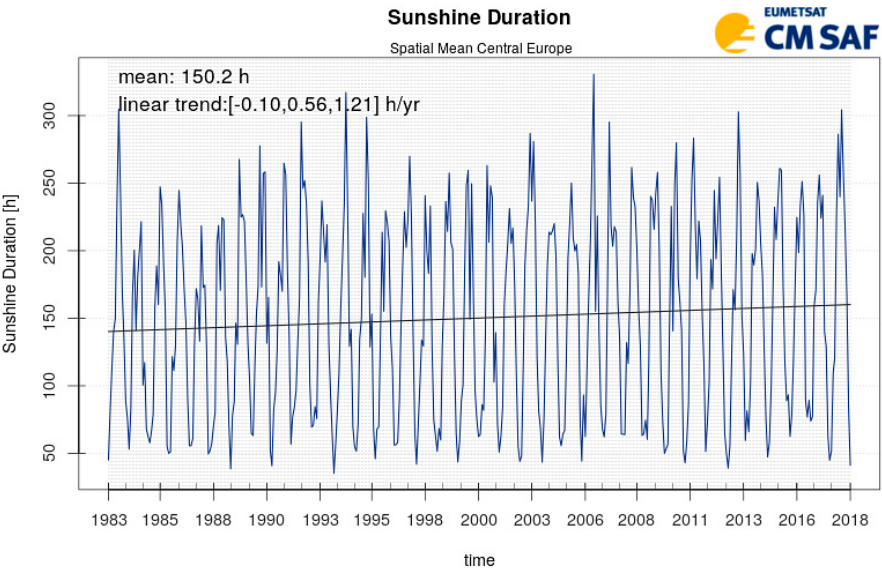
Figure 10. Spatial mean of SDU monthly sums from 1983 to 2018 for Central Europe.